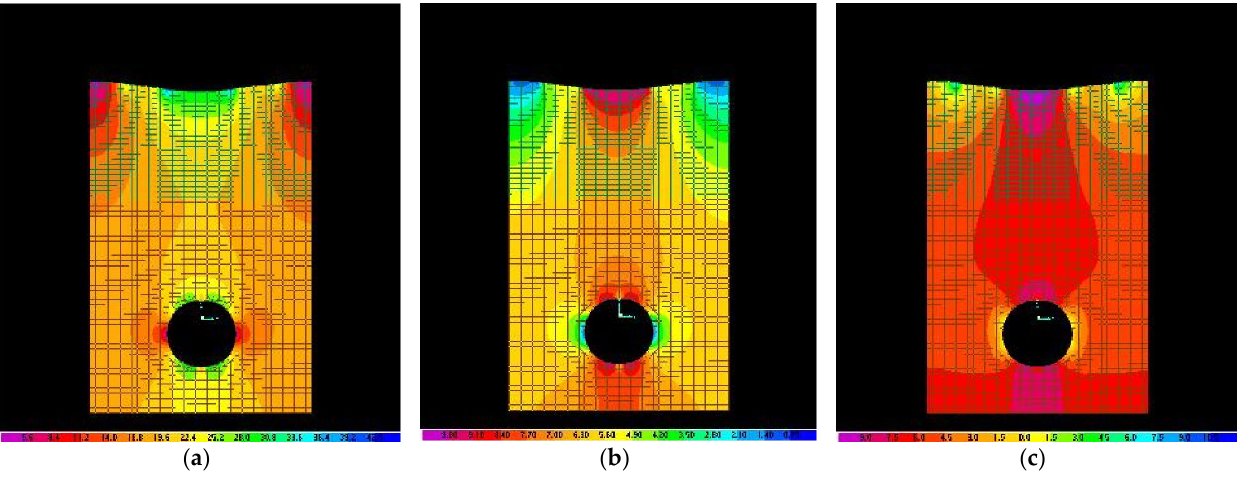
Figure 3. Examples of answers of numerical models representing a buried pipe in the hypothesis of the gravitational application of a dynamic overpressure: ( a , b )—main normal stress (N/mm 2 ), ( c )—absolute displacements (mm).